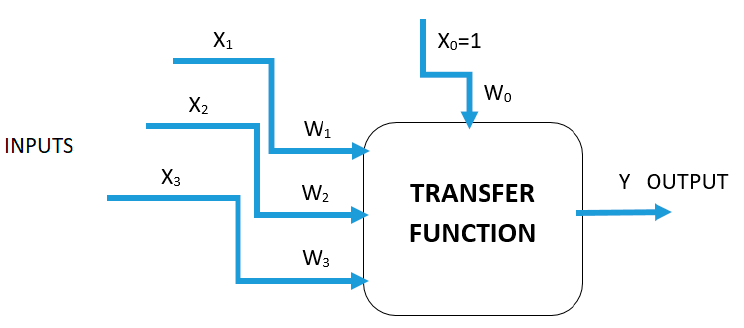
Figure 3. Symbolic representation of the neuron’s model.